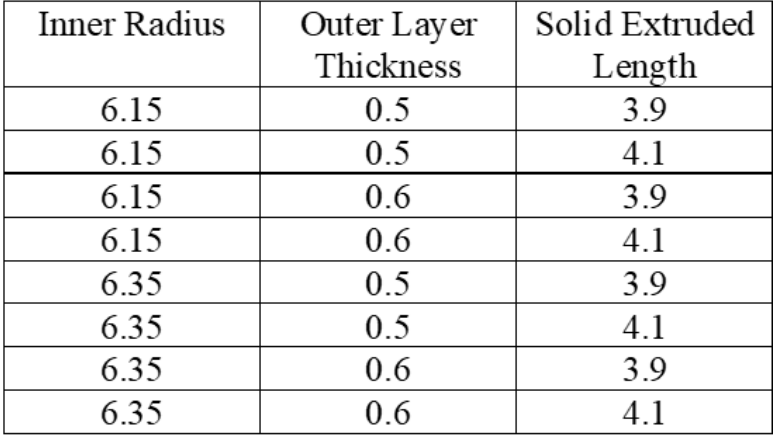
Figure 15. Full factorial design matrix with input parameter values.